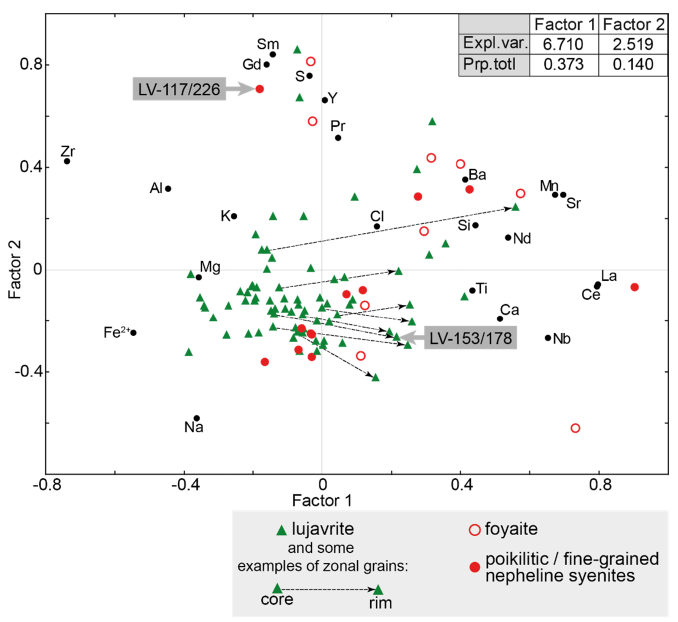
Figure 6. Results of factor analyses of data on the chemical composition of EGM from Eudialyte complex. Expl.var.—explained variance; Prp.totl—proportion of total variance. The meaning unit is factor score for both axis.